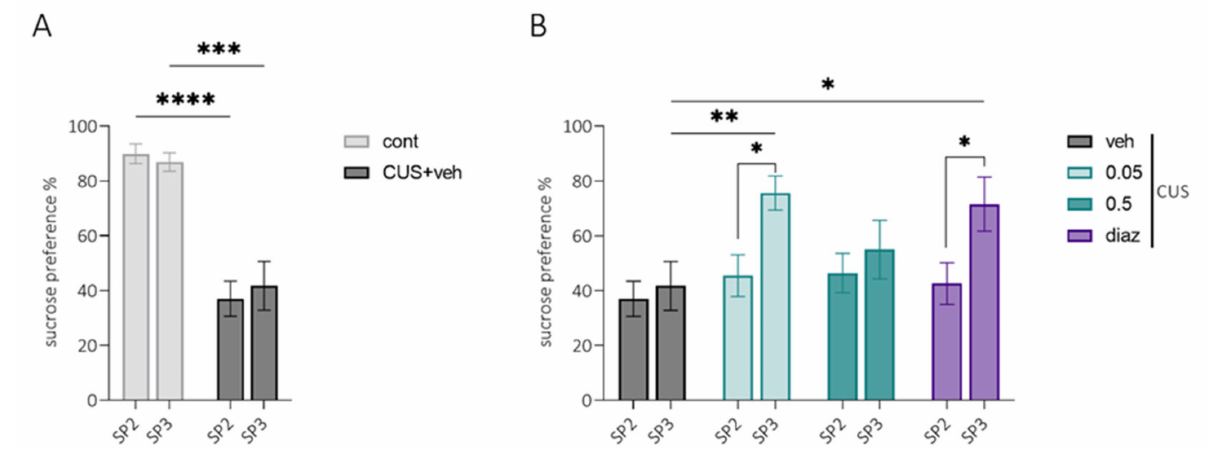
Figure 5. Sucrose preference index (%) of rats several (1–5) days after (SP2) and 3.5 weeks after CUS exposure (SP3). At the SP3 point, animals received 16 injections of either LCGA-17 at a dose of 0.05 and 0.5 mg/kg or diazepam 0.5 mg/kg or the vehicle. ( A ) the sucrose preference index (%) of rats from the control and stressed groups showed treatment effects (F (4, 40) = 11.92, p < 0.0001), test effects (F (1, 40) = 10,52, p = 0.0025), and treatment × test interactions (F (4, 40) = 2666, p = 0.047). CUS exposure resulted in the persistent reduction of sucrose preference in comparison with control groups several days after (SP2, p < 0.0001) and 3.5 weeks after stress (SP3, p = 0.0002); ( B ) Sucrose preference index (%) of stressed groups of rats that showed a treatment effect (F (4, 40) = 11.92, p < 0.0001), test effect (F (1, 40) = 10,52, p = 0.0025), and treatment × test interaction (F (4, 40) = 2666, p = 0.047). LCGA-17 in a dose of 0.05 mg/kg improved the hedonic behavior, and the same effect was observed in the diazepam-treated group. * p < 0.05, ** p < 0.01, *** p < 0.001, and **** p < 0.0001;